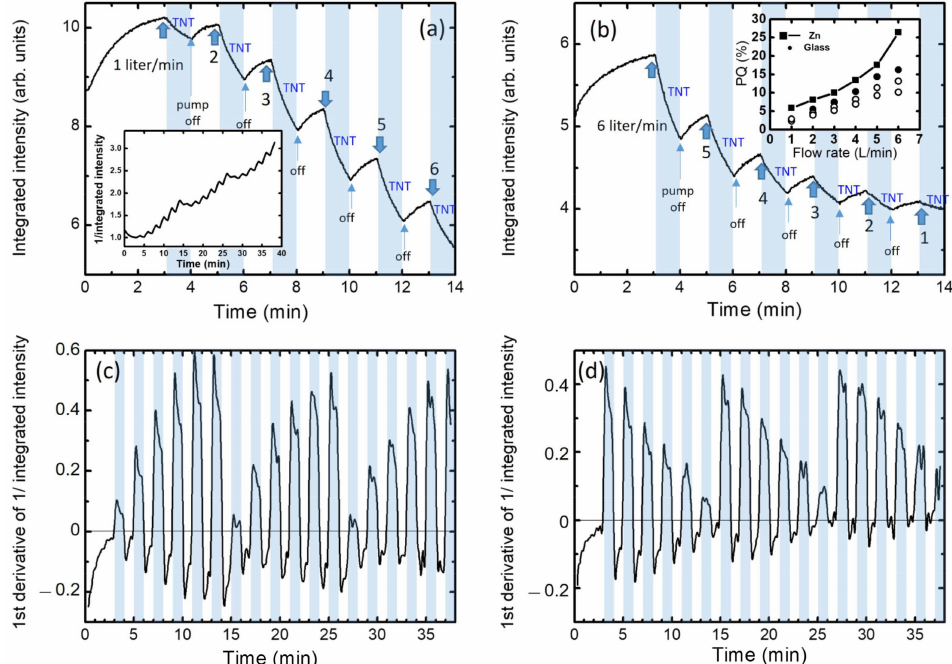
Figure 5. Time-dependent integrated PL intensity with various flow rates observed with glass/PEE films. The flow rate was controlled with a pump, as shown in Figure 1. The pump was turned on and off for a minute for each flow rate. A closed cycle was used while the TNT vapor was already inside of the sample chamber. Blue shaded parts indicate the pump-on period. The flow rates were changed ( a ) from 1 L/min to 6 L/min and ( b ) from 6 L/min to 1 L/min. The cycle was repeated 3 times and the inset of ( a ) shows the reciprocal of the normalized intensity. The inset of ( b ) shows the PQ (%) as a function of flow rates for the repeated cycles. The PQ from Zn/PEE film is also included. ( c , d ) represent the first derivatives of the reciprocal normalized integrated intensities of ( a , b